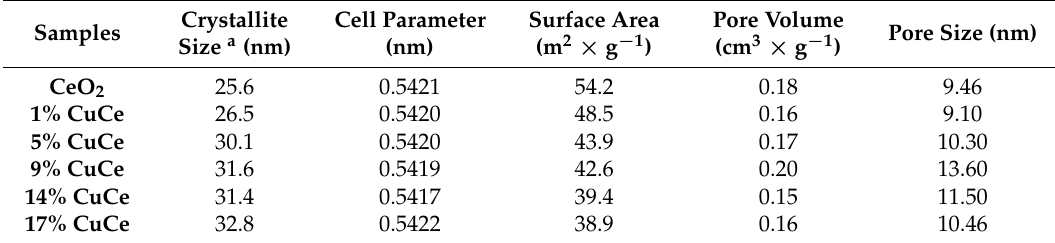
Table 1. Physical properties of various